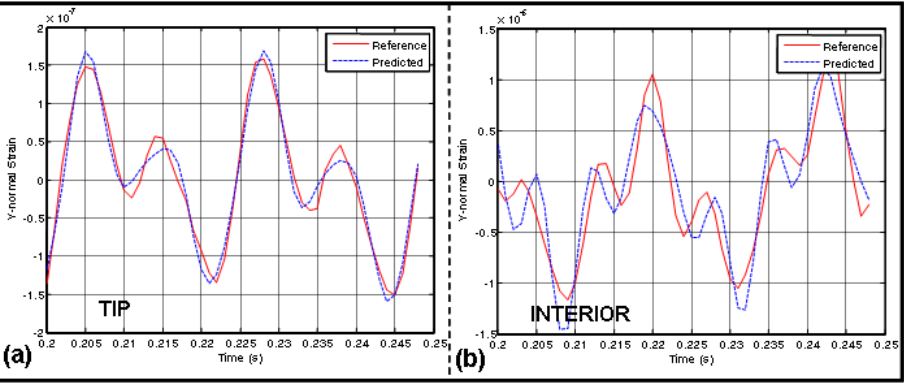
Fig. 5. Overlay of strain response of box-beam at (a) tip and (b) interior location; predicted solution used first 6 modes in expansion